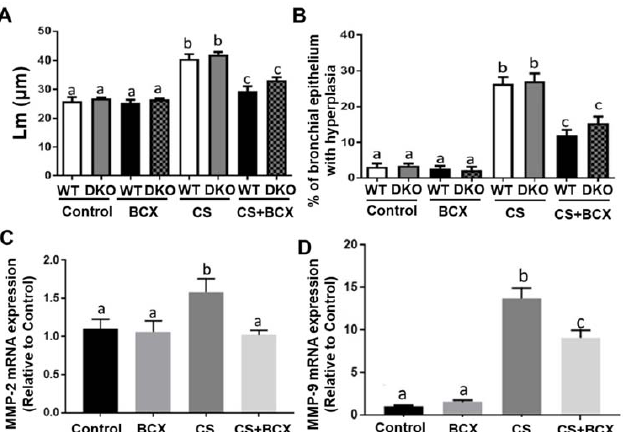
Figure 4. BCX supplementation significantly inhibited CS-exposure-induced emphysema and proliferative lung lesions in WT mice and BCO1 − / − /BCO2 − / − DKO mice. Quantification of H&E stained (at 10×) lung pathology of ( A ) alveolar diameter expressed as mean linear intercept (Lm, µM) and ( B ) percentage of hyperplastic of the bronchial epithelium in WT and DKO mice. Shown are the graphical representations of mRNA expression of ( C ) MMP-2 and ( D ) MMP-9 quantified by real-time PCR in the lungs of DKO mice ( n = 7–9 for each group). β -actin was used as a loading control. Groups: Control, non-CS-exposed mice without supplementation; BCX, non-CS-exposed mice with BCX supplementation; CS, CS-exposed mice without supplementation; CS+BCX, CS-exposed mice with BCX supplementation. Significant differences between groups were analyzed by one-way ANOVA and are denoted by different letters ( p < 0.05). BCX, β -cryptoxanthin; CS, cigarette smoke; DKO, double knockout; BCO1, β -carotene-15,15 ′ -oxygenase; BCO2, β -carotene-9 ′ ,10 ′ -oxygenase; and MMP, matrix metalloproteinase.